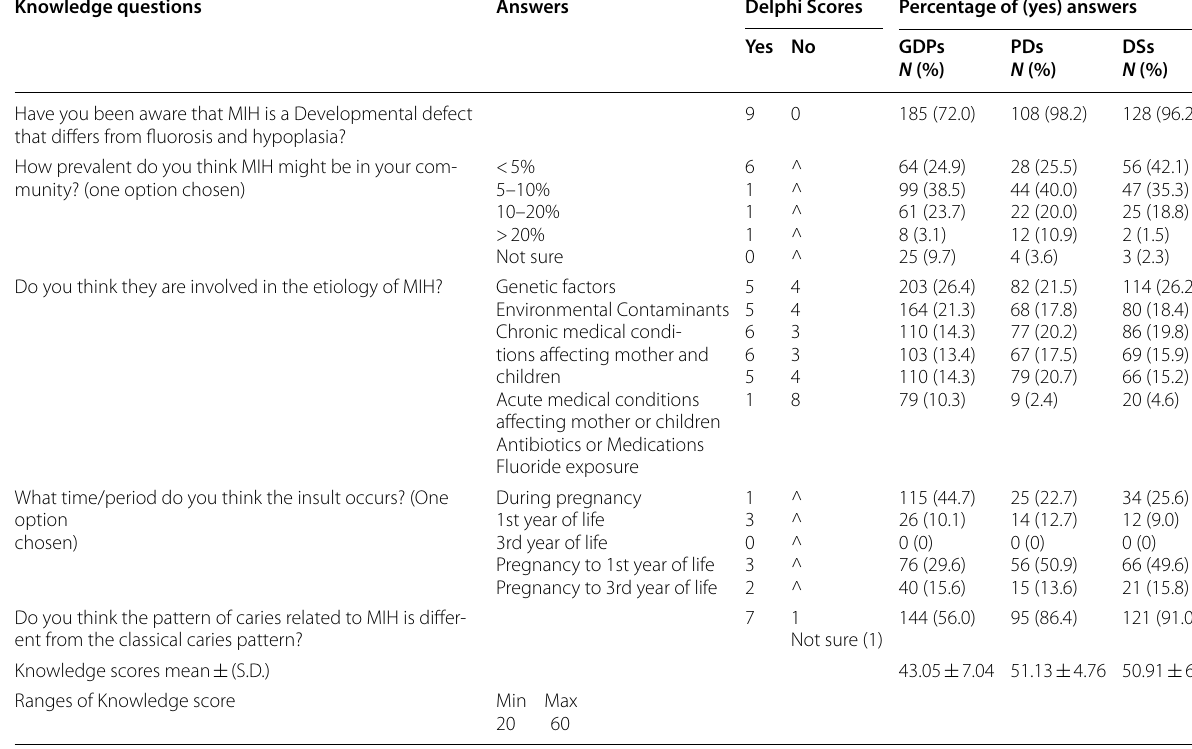
Table 1 Scores for each of the MIH knowledge questions as agreed using Delphi